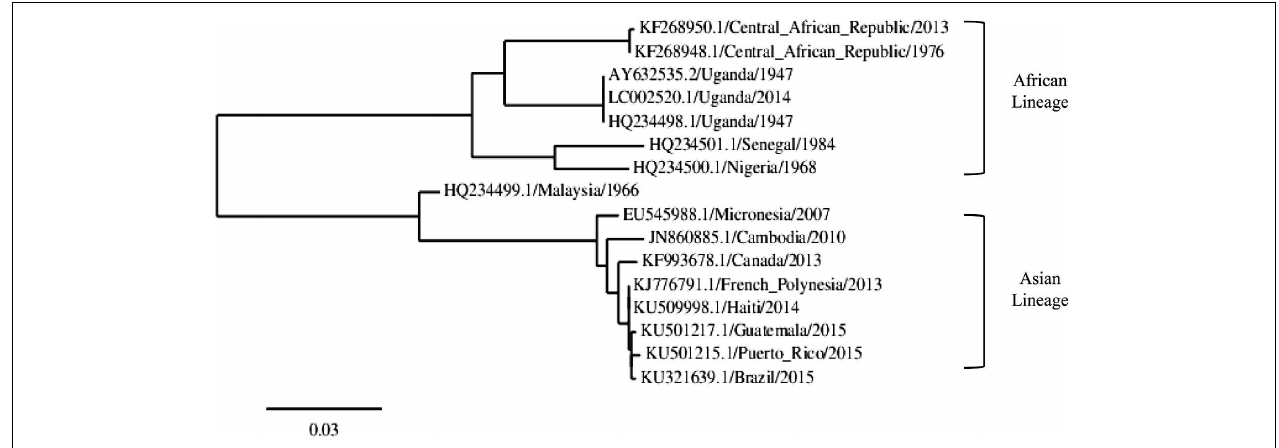
FIGURE 4 | Representative phylogram showing the relationships between ZIKV strains. The accession number, country of isolation and year is displayed in the tree. The scale indicates 0.03 substitutions/site. The tree was based on complete NS5 nucleotide sequence, built from a multiple alignment using Clustal omega and